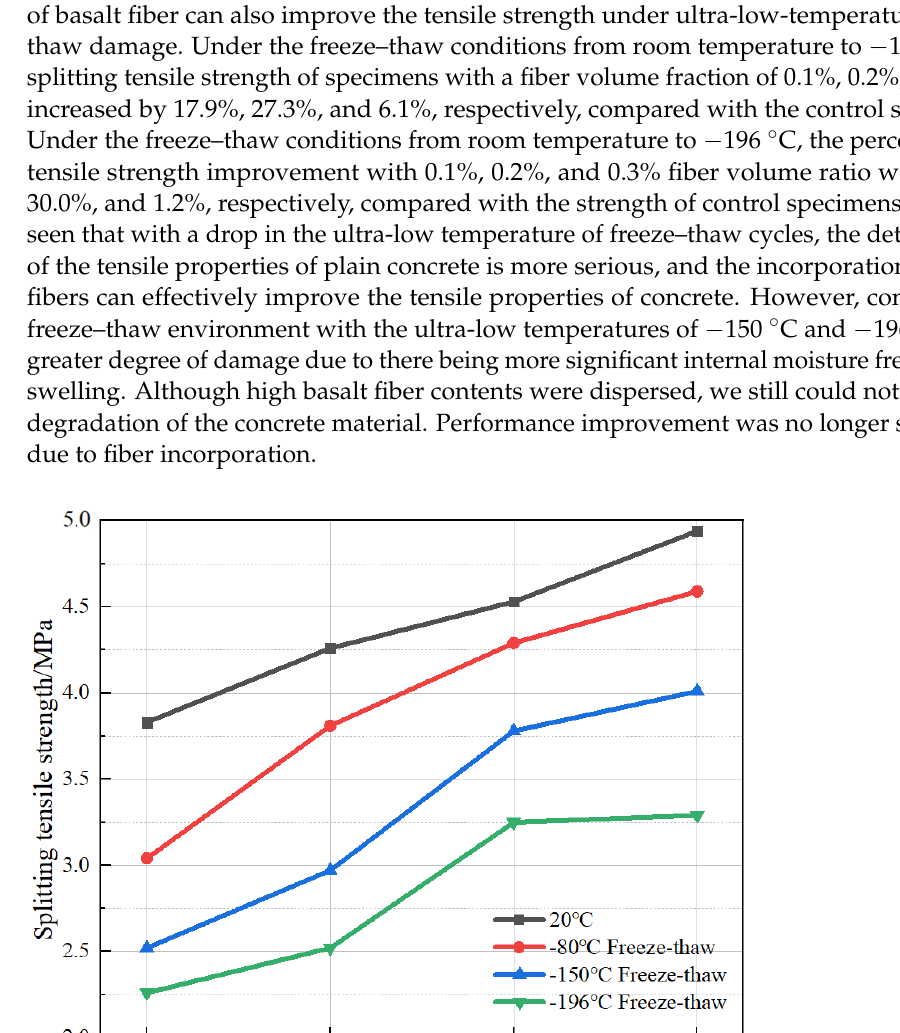
Figure 17. Effect of the number of freeze–thaw cycles on the splitting tensile strength of BFRC.